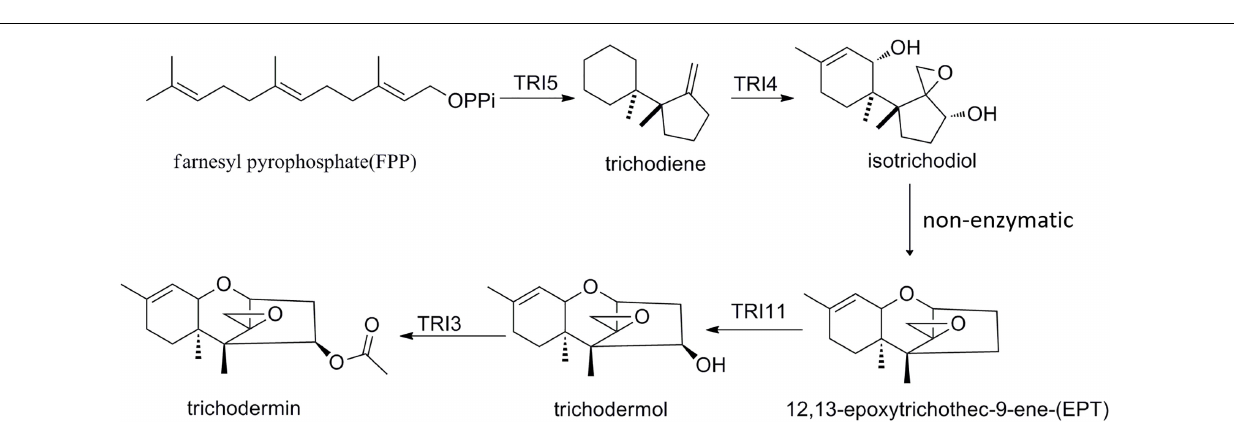
FIGURE 8 | The proposed trichodermin biosynthetic pathway in Trichoderma taxi